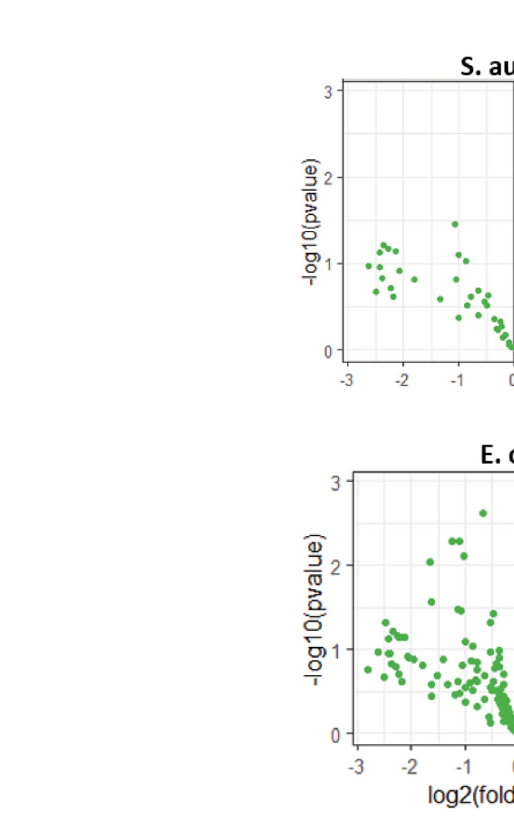
FIGURE 4 Volcano plots for proteins enriched in S. aureus or E. coli